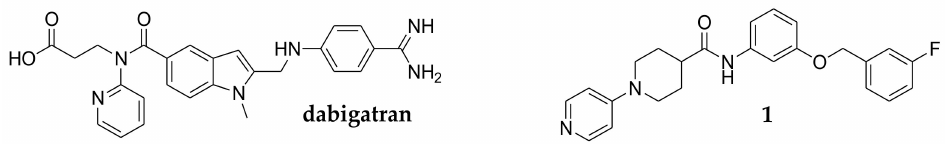
Figure 1. Dabigatran and the in vitro equipotent isonipecotamide-based thrombin inhibitor 1